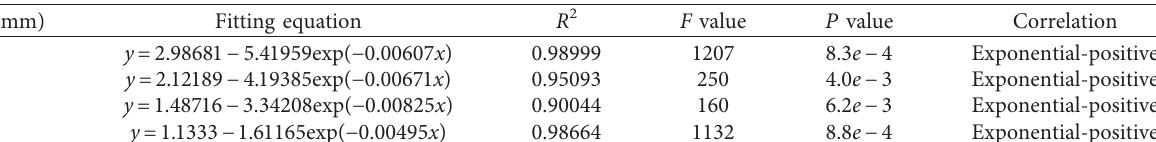
Figure 10: The fitting curve between PCF and width of rock plate. Table 3: Regression analysis results between width and PCF.